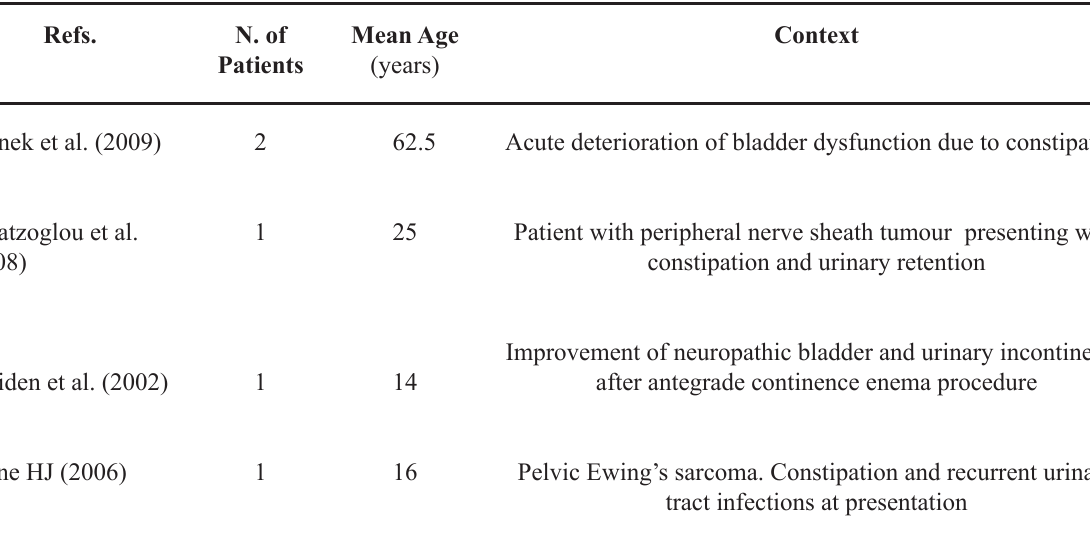
Table 5 – Case reports on constipation and LUTS in the literature (neuropathic patients).